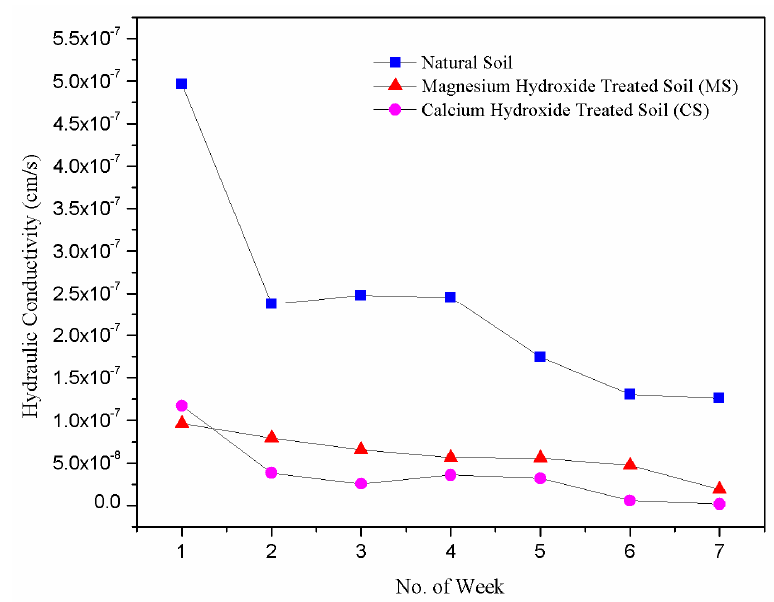
Figure 3. Variations of hydraulic conductivity for untreated and nanoparticles-treated soil specimens over permeation time.